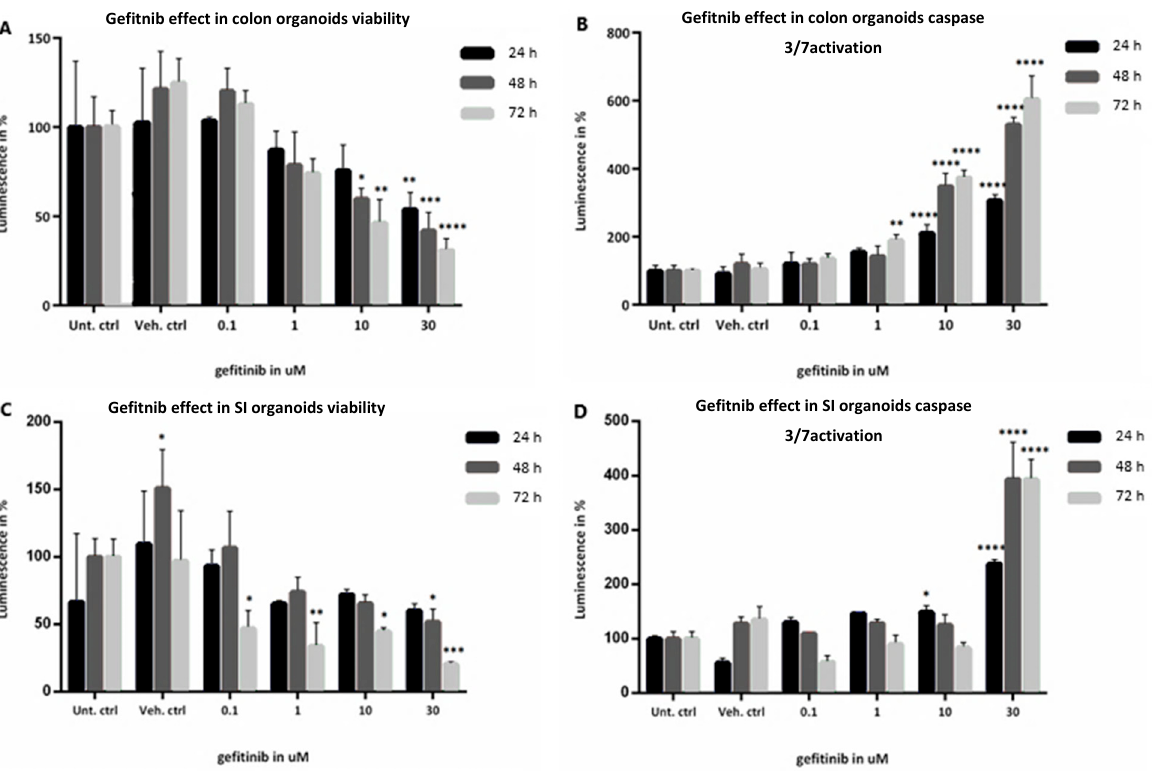
Figure 3. ( A – D ): Evaluation of viability determined by ATP levels and caspase 3/7 activation of healthy colon ( A and B , respectively) and SI ( C , D , respectively) organoids when exposed to 0.1, 1, 10, and 30 µM gefitinib for 24 h in black, 48 h in dark grey and 72 h in light grey, compared with Untreated controls. Values are in % of luminescence. For each time point the average of Unt. Ctrl was set to 100%. SD was calculated for each condition. Legend: Ctrl, control; SD, standard deviation; SI, small intestine; Unt, untreated; Veh, vehicle (with 0.1% DMSO). * p -value = 0.01; ** p -value = 0.003; *** p -value = 0.0004; **** p -value = 0.0001.